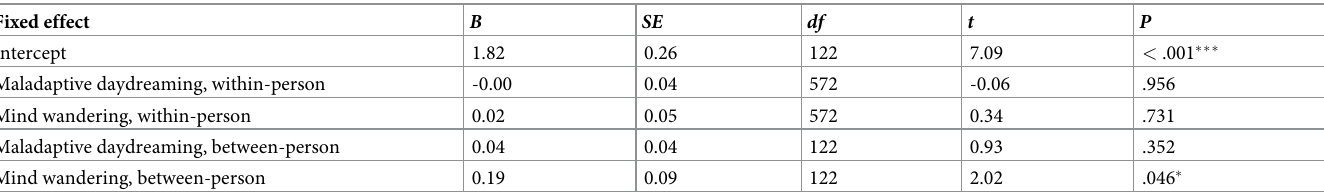
Table 2. Multilevel Analyses with Mind wandering and Maladaptive daydreaming last day as predictors of Sleep Disturbances that Night. Fixed